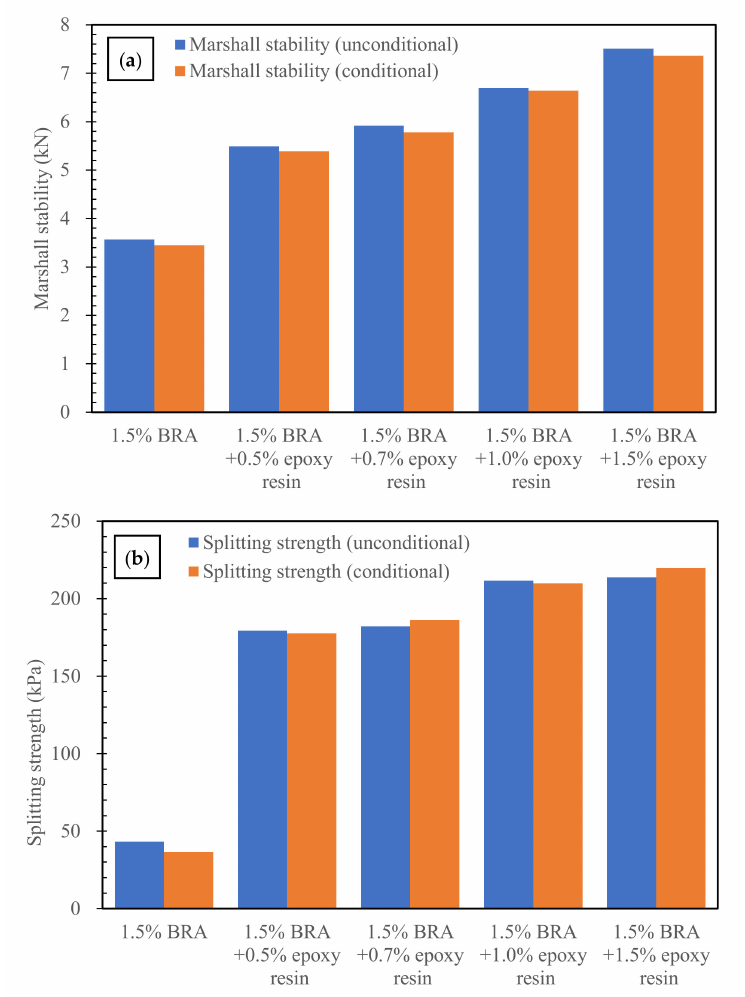
Figure 6. Effects of low dosages of epoxy resin on the mechanical properties of BRA-rejuvenated RAP: ( a ) Marshall stability; ( b ) splitting